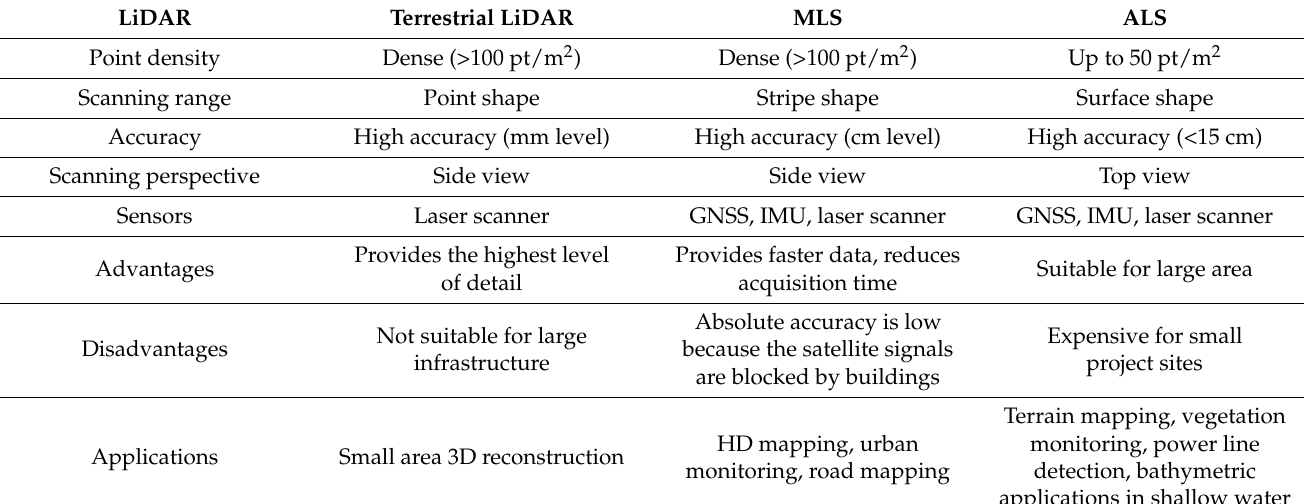
Table 3. Comparison of LiDAR systems on different